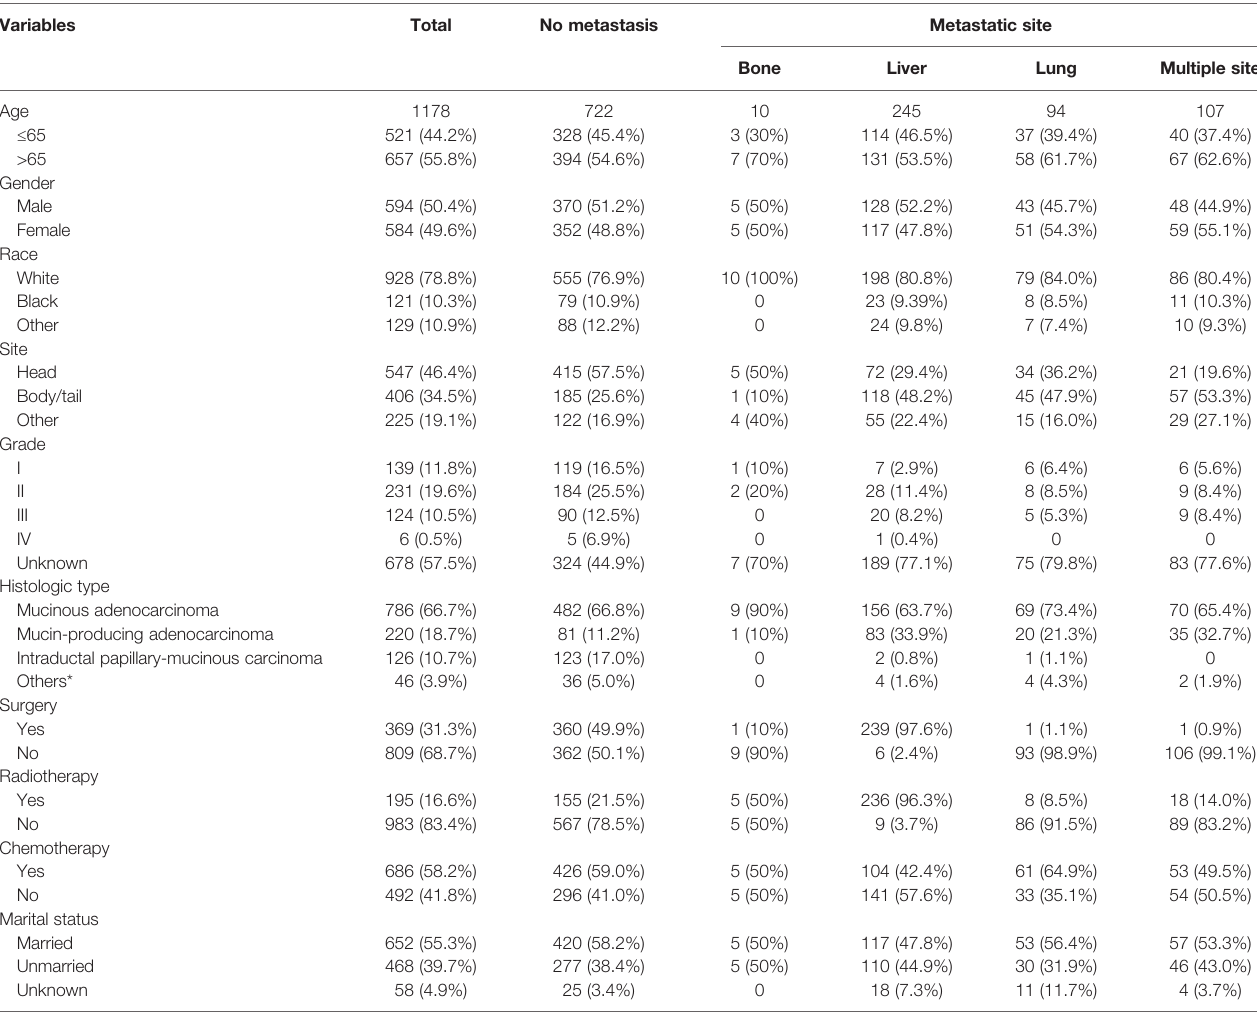
TABLE 1 | Clinical characteristics of patients with IPMN with associated invasive